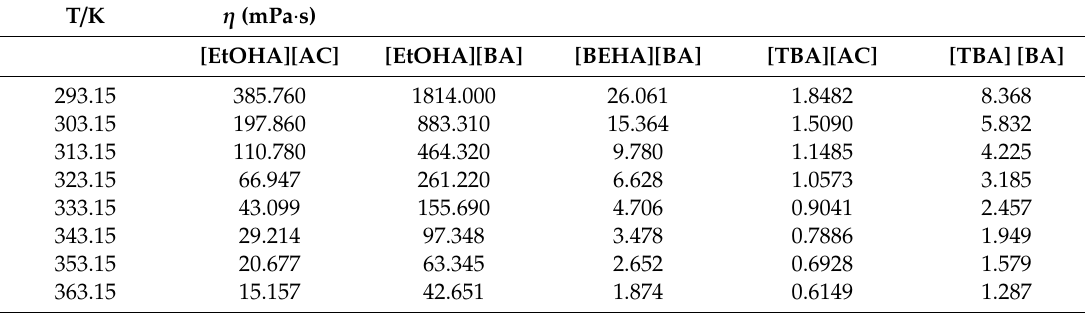
Table 3. Dynamic viscosity ( η ) values of ionic liquids from 293.15 K to 363.15